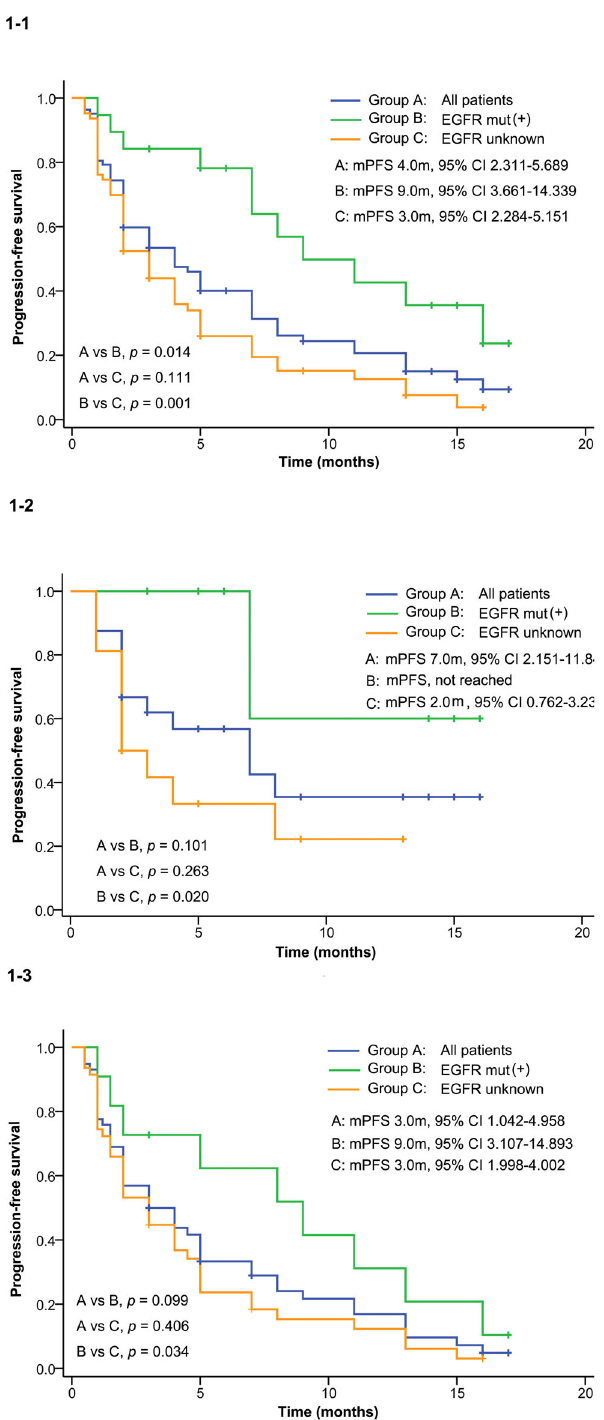
Figure 1. Progression-free survival. 1–1 shows the PFS in all patients in this study, 1–2 shows the PFS in first line subset, 1–3 shows the PFS in second/third line subset. small cell lung cancer, and robust activity of icotinib in patients with EGFR mutation. In the second/third line subset (n= 58), the PFS were 3.0 m for all patients, 9.0 m for EGFR mutation patients and 3.0 m for EGFR status unknown patients. The OS was 10.0 for all patients,